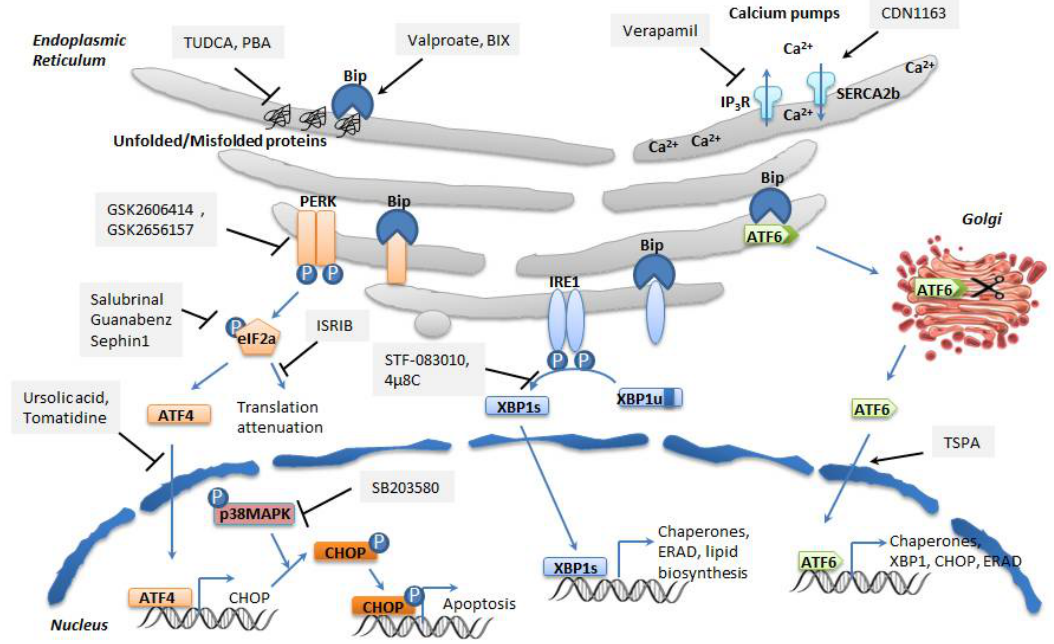
Figure 5. Targeting ER stress and the UPR with chemical and pharmacological drugs in metabolic diseases. TUDCA and PBA are chemical chaperones that improve protein folding in a non-specific manner. Valproate and BIX Bix are two small molecules, BIP Bip inducers. Verapamil is a calcium channel blocker, which includes the calcium release channel IP3R. CDN1163 is a small allosteric activator of SERCA2b. GSK2606414 and GSK2656157 are PERK inhibtors. Salubrinal is a small molecule, which reduces dephosphorylation of eIF2α. Ursolic acid and tomatidine are inhibitors of ATF4. SB203580 is a specific inhibitor of the p38 MAP kinase, which phosphorylates CHOP. STF- 083010 and 4µ8C are inhibitors of IRE1 RNase activity. The small molecule 2-[5-[1-(4- chlorophenoxy)ethyl]-4-phenyl-4 H -1,2,4-triazol-3-yl]sulfanyl- N -(1,5-dimethyl-3-oxo-2-phenyl-2,3- dihydro-1 H -pyrazol-4-yl)acetamide (TSPA) is a small allosteric activator, which functions as an ATF6α translocation inducer. Abbreviations: inositol 1,4,5-trisphosphate(IP3R) receptorIP3R (inositol 1,4,5-trisphosphate) receptor. Grey boxes contain the name of the drugs (sharp arrows, activators; bar- ended arrows,